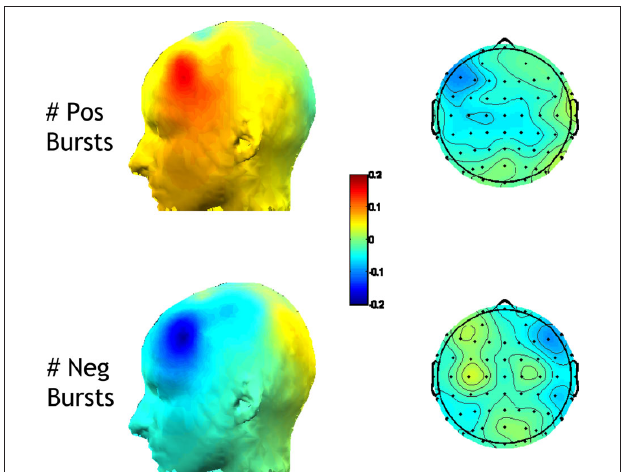
FIGuRE 5 | Correlations of peri-burst alpha asymmetry from sites F5 and F6 [ln(F6) − ln(F5)] with the conventional FFT-derived asymmetry score from all homologous EEG sites [ln(Right) − ln(Left)]. Correlations are shown separately for positive bursts (top left) and negative bursts (bottom left) and combined (right). Because asymmetry scores are difference scores, only one side of the head is depicted, as the opposite side would show identical topography. Anatomical specificity is observed for positive and negative bursts, and all bursts combined, but note that the scale for the combined is larger than either the positive or negative bursts alone, indicating that combining across both positive and negative bursts produces a metric that is most closely aligned with the conventional asymmetry scores, accounting for 42% of the variance in conventional asymmetry scores at F6–F5. Maps were constructed by mapping Pearson correlations using the function headplot from EEGLab (Delorme and Makeig, 2004).